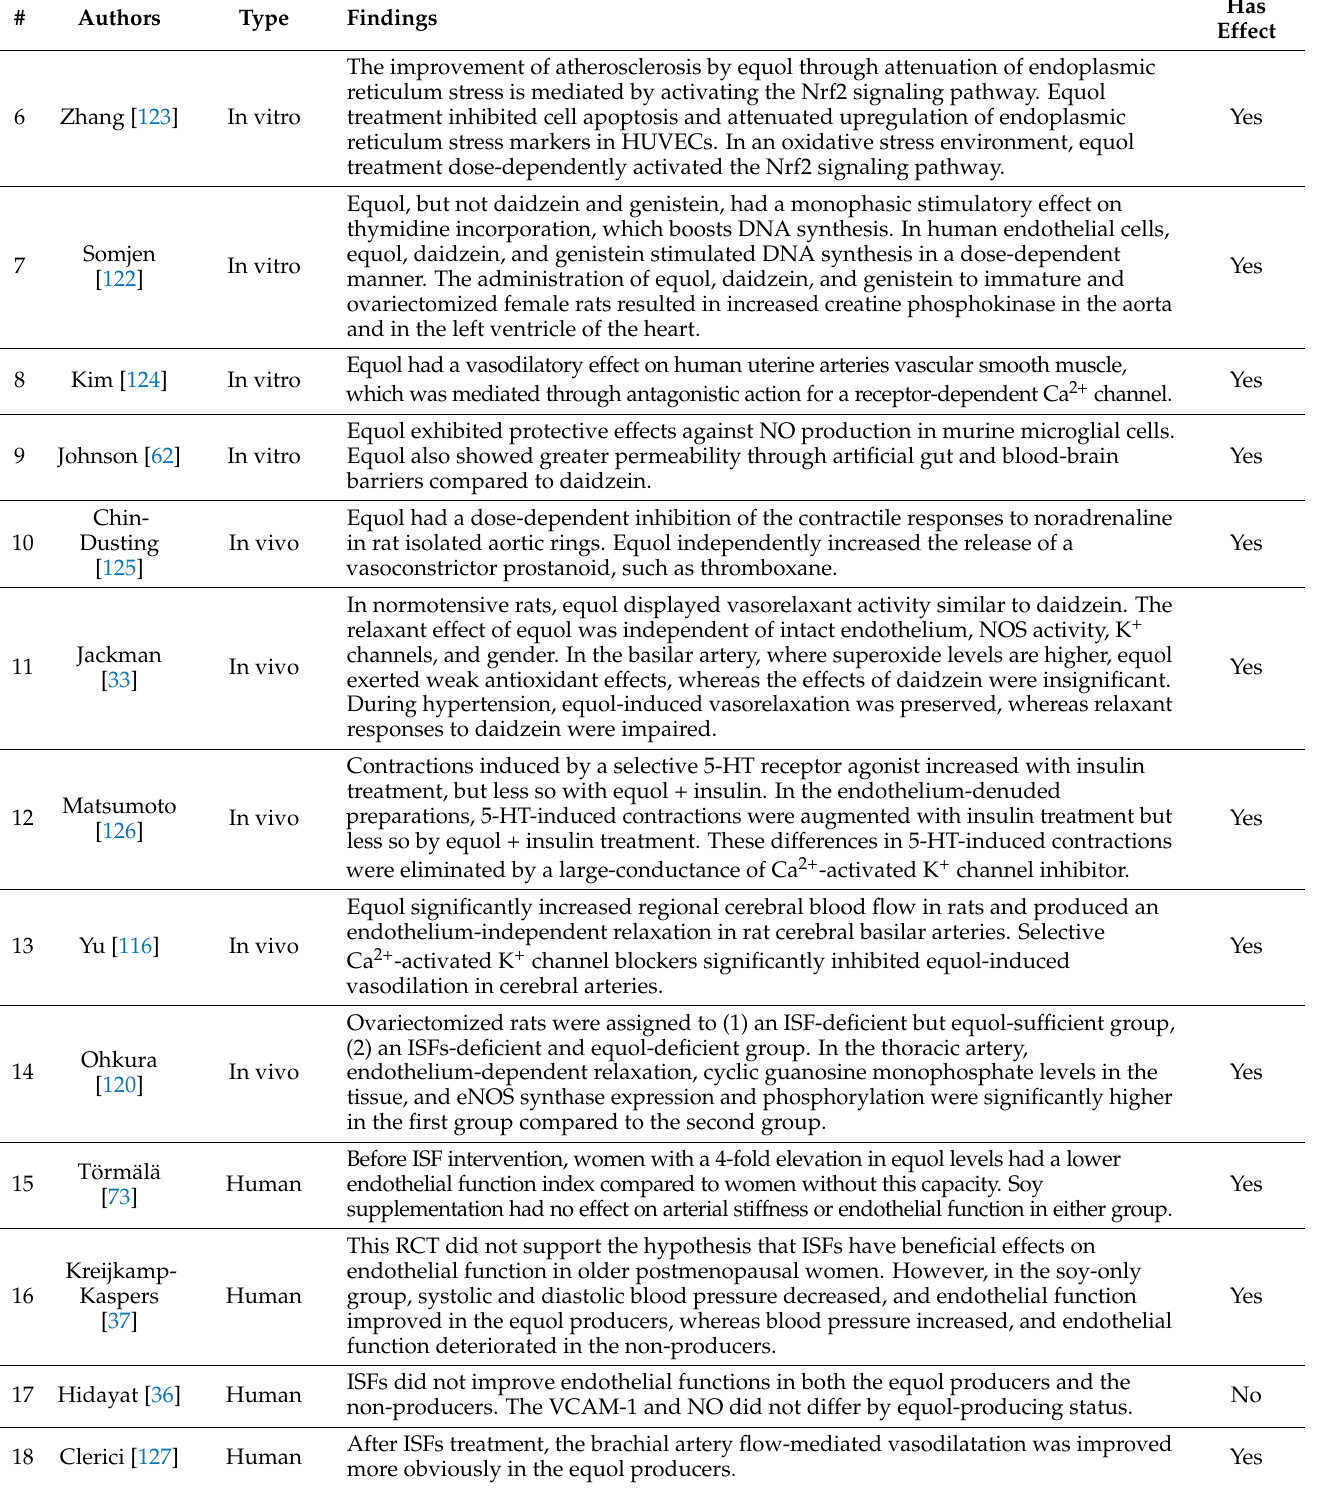
Abbreviations: ERK1/2, extracellular signal-regulated protein kinases 1 and 2; PI3K/Akt, protein kinase 1/2 and phosphatidylinositol 3-kinase/protein kinase B; NOS, nitric oxide synthase; NO, nitric oxide; ROS, reactive oxygen species; HUVEC, human umbilical vein endothelial cell; eNOS, endothelial nitric oxide synthase; HO-1, heme oxygenase-1; NQO1, NADPH-quinone oxidoreductase 1; Nrf2, nuclear factor-erythroid 2-related factor 2; bAECs, bovine aortic endothelial cell; MAPK, mitogen-activated protein kinase; HUVECs, human umbilical vein endothelial cells; cfPWV, carotid-femoral pulse wave velocity; VCAM-1, vascular cell adhesion molecule-1; 5-HT, 5-hydroxytryptamine; Ca, calcium; K,